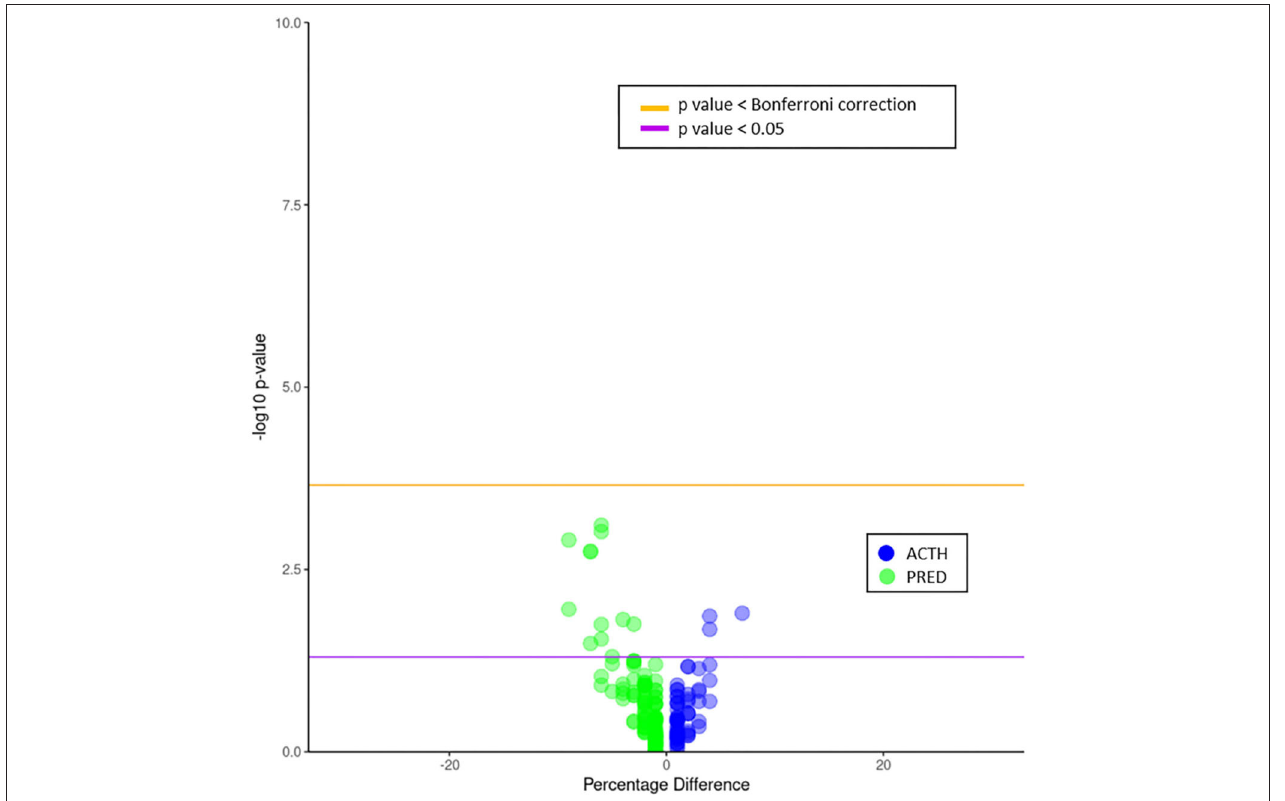
FIGURE 3 | Volcano plot of phecode differences between ACTH and PRED patients. Frequencies are plotted as negative log 10 of the p -value over the percentage difference. The purple line indicates a p -value of 0.05; the orange line indicates an adjusted p -value using the Bonferroni correction. Neither drug cohort had phecode frequencies above the adjusted p -value. However, the PRED cohort had two neurological phecode frequencies above the p < 0.05 line, abnormal findings on study of brain/nervous system, and infantile cerebral palsy (percentage differences of 7% for both phecodes). The ACTH cohort also had a neurological phecode frequency above p < 0.05 line, hemiplegia (percentage difference of